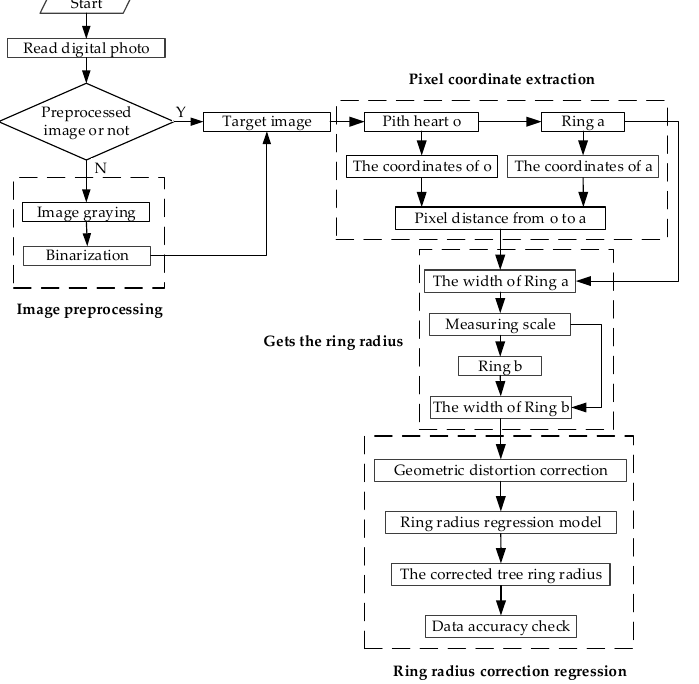
Figure 3. Flow chart of the experiment. N means the image has not been preprocessed; Y indicates that the image has been preprocessed.